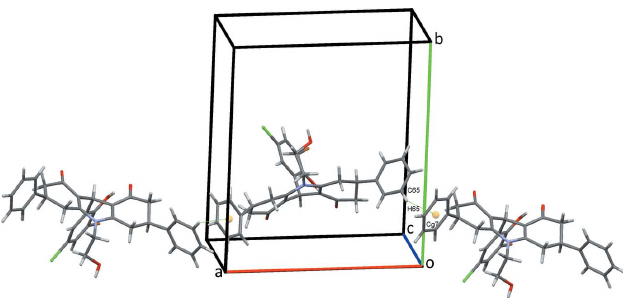
Figure 3 Chains of molecules of (I) along a . C—H (cid:2)(cid:2)(cid:2) (cid:2) contacts are shown as dotted green lines with ring centroids shown as coloured spheres.